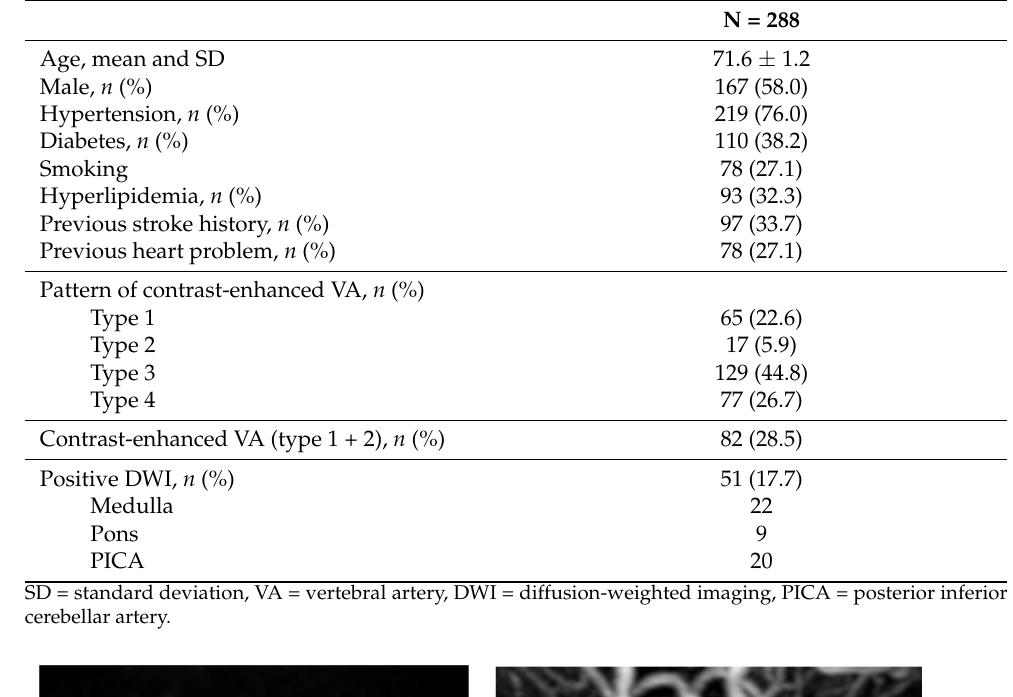
Table 1. Demographic of this study.